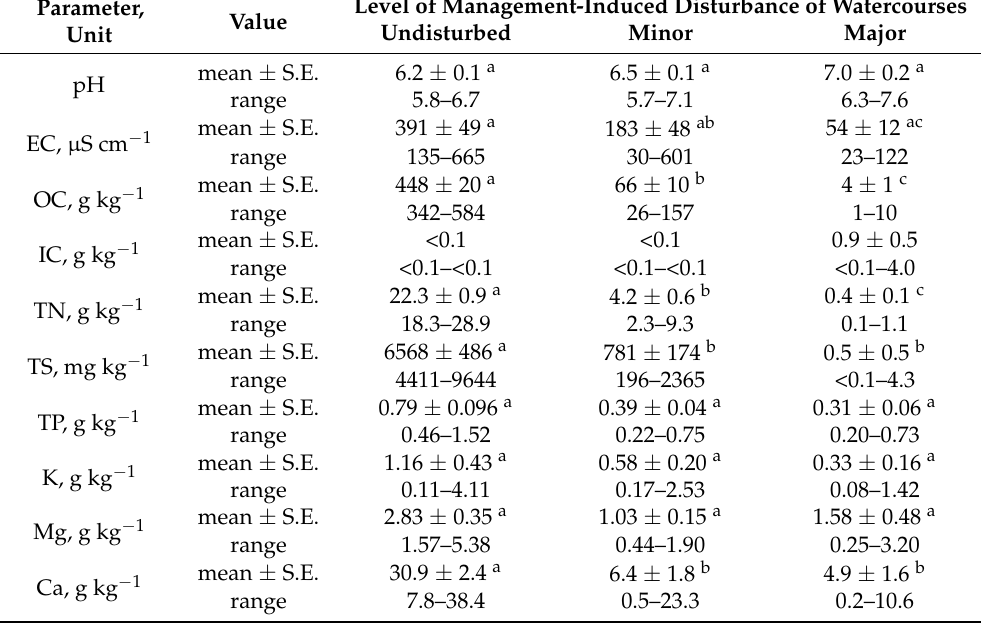
Table 2. General chemical characteristics of the sediments compared to the level of management- induced disturbance in the watercourses. Different letters represent statistically significant differences between groups representing different levels of management-induced disturbance in the watercourses ( n = 32).